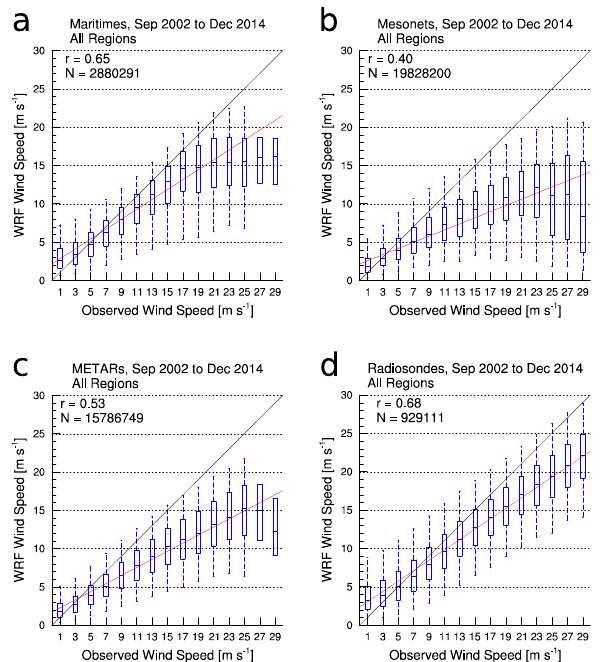
Figure 7. Box plots of model / observation pairs of wind speed for the ( a ) maritime, ( b ) mesonet, ( c ) METAR, and ( d ) radiosonde networks, spanning September 2002–December 2014. The thin black line is the 1:1 line, and the thin red line is the regression line. The regression coefficient (r) and sample size (N) are given in the top-left corner of each panel. Each bin width is 2.0 m s − 1 . Each box depicts the median and middle 50% of the bin. Dashed lines extend to the 5th and 95th percentiles when the bin contains at least 1000 points.